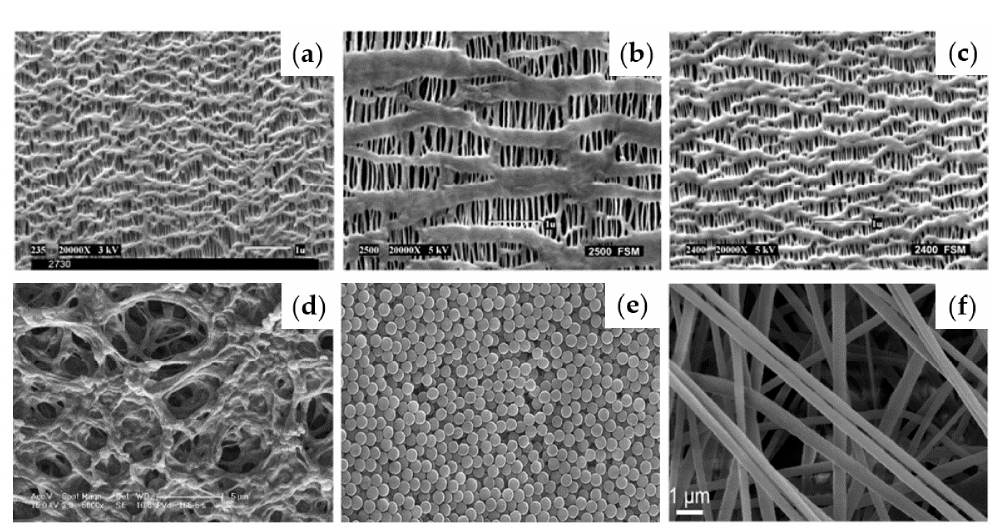
Figure 4. SEM images of the surfaces of various separators: ( a ) Celgard 2730 (PE), ( b ) Celgard 2500 (PP), ( c ) Celgard 2400 (PP). Reprinted with permission from [41]. Copyright (2004) American Chemical Society. ( d ) PVDF membrane (ethanol precipitation bath). Reprinted with permission from [57]. Copyright (2008) Elsevier B.V. ( e ) PMMA particles Reprinted with permission from [58] Copyright (2018) CC BY. ( f ) PAN nanofibers Reprinted with permission from [59] Copyright (2019)